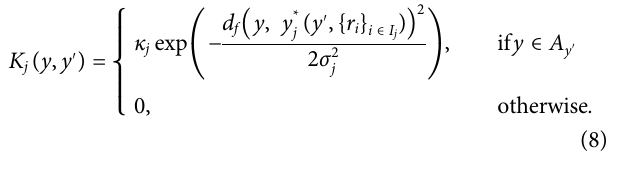
FIGURE 5 | Theta* algorithm is used on a 8-connected grid graph, G ✳ (top right inset) for computing geodesic distances as well as control velocities for the pursuers.